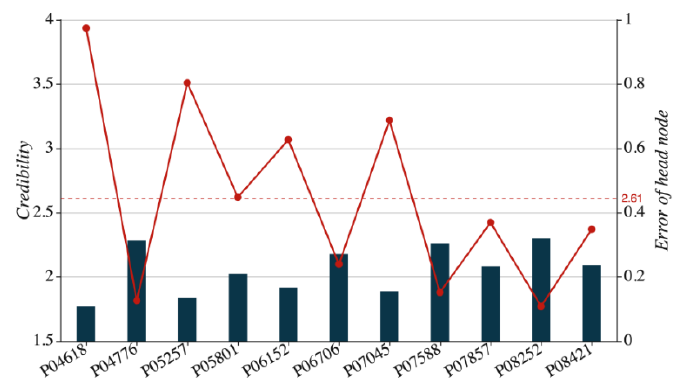
Figure 9. Credibility analysis of key nodes.